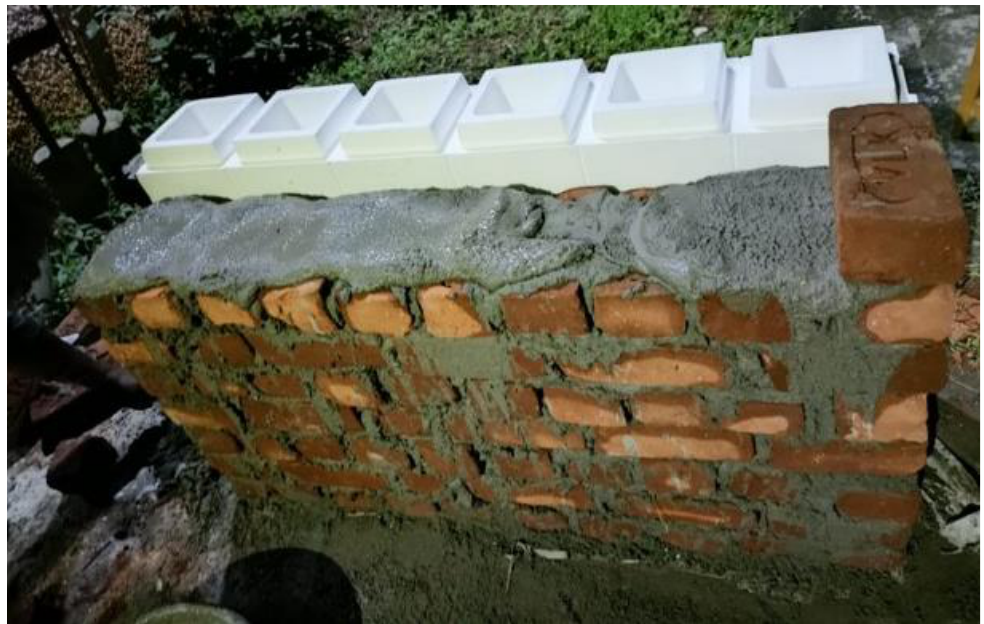
Figure 5. Construction of the conventional brick masonry.